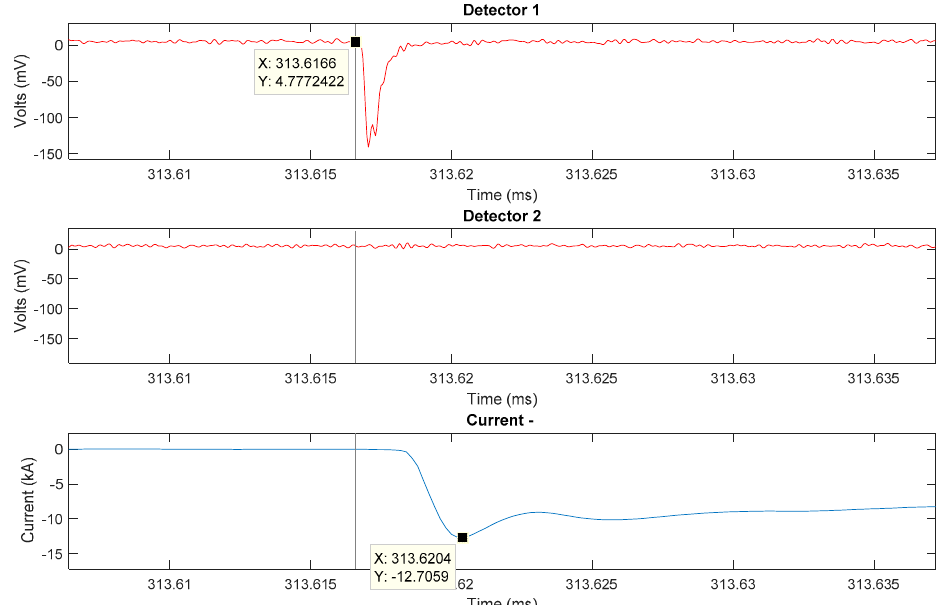
Figure 6. X-rays from a subsequent stroke of a flash that occurred on 02 March, 2015, of the type ICC RS . The time t = 0 corresponds to 20:54:37.247308 UTC. The flash contains nine initial continuing current (ICC) pulses followed by four RSs. The occurrence of the X-ray is about 3 µs prior to the current peak of the third RS. The X-ray peak, appearing in the un-attenuated detector, could be an accumulation of multiple photons. The energy of the peak (calculated by simply multiplying the peak voltage of the burst by the calibration factor) is about 700 keV. The timestamp of the RS is 20:54:37.560928 UTC.